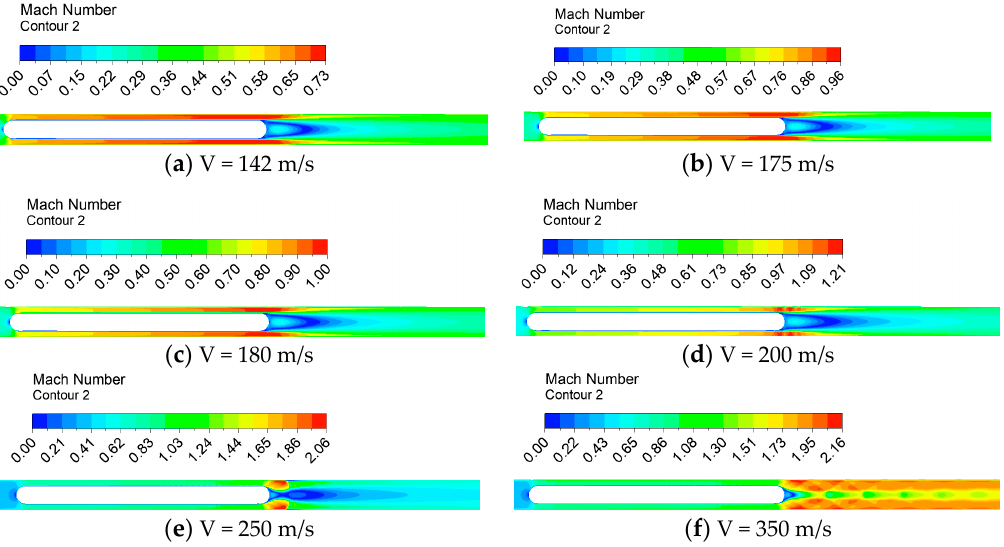
Figure 7. Mach number contours around pod for various pod speeds.